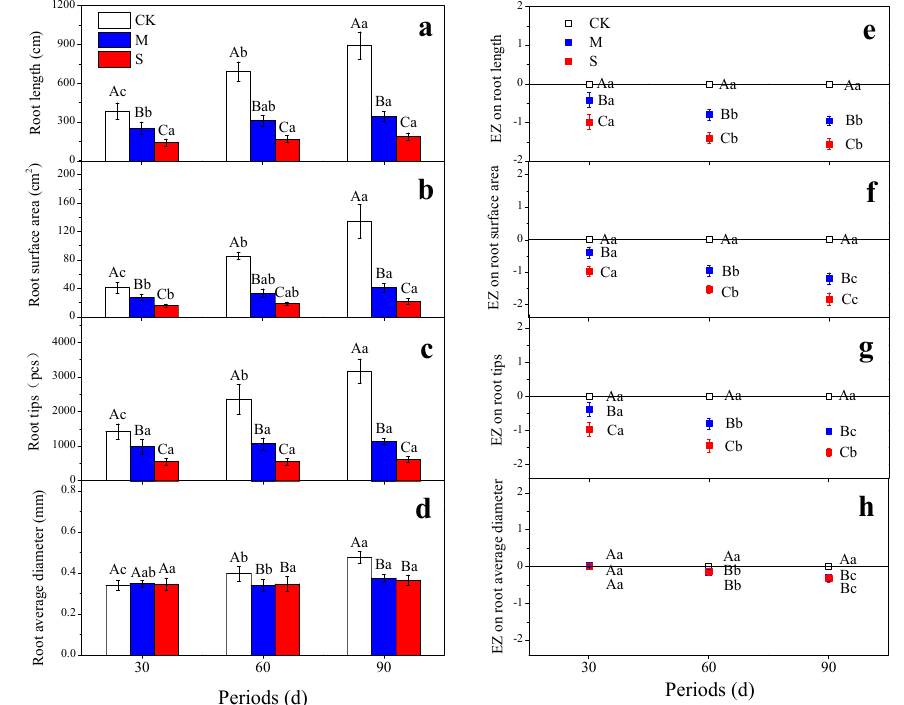
Figure 3. Effects of different drought treatments on root length ( a ), root surface area ( b ), root tips ( c ), root average diameter ( d ), EZ on root length ( e ), EZ on root surface area ( f ), EZ on root tips ( g ), and EZ on root average diameter ( h ) during different periods. The different capital letters denote significant differences between treatments ( p < 0.05), and the different lowercase letters denote significant differences between periods ( p < 0.05). The histograms represent root growth parameters, and the scatter diagrams represent the EZ of drought treatments on root growth. EZ: effect size.